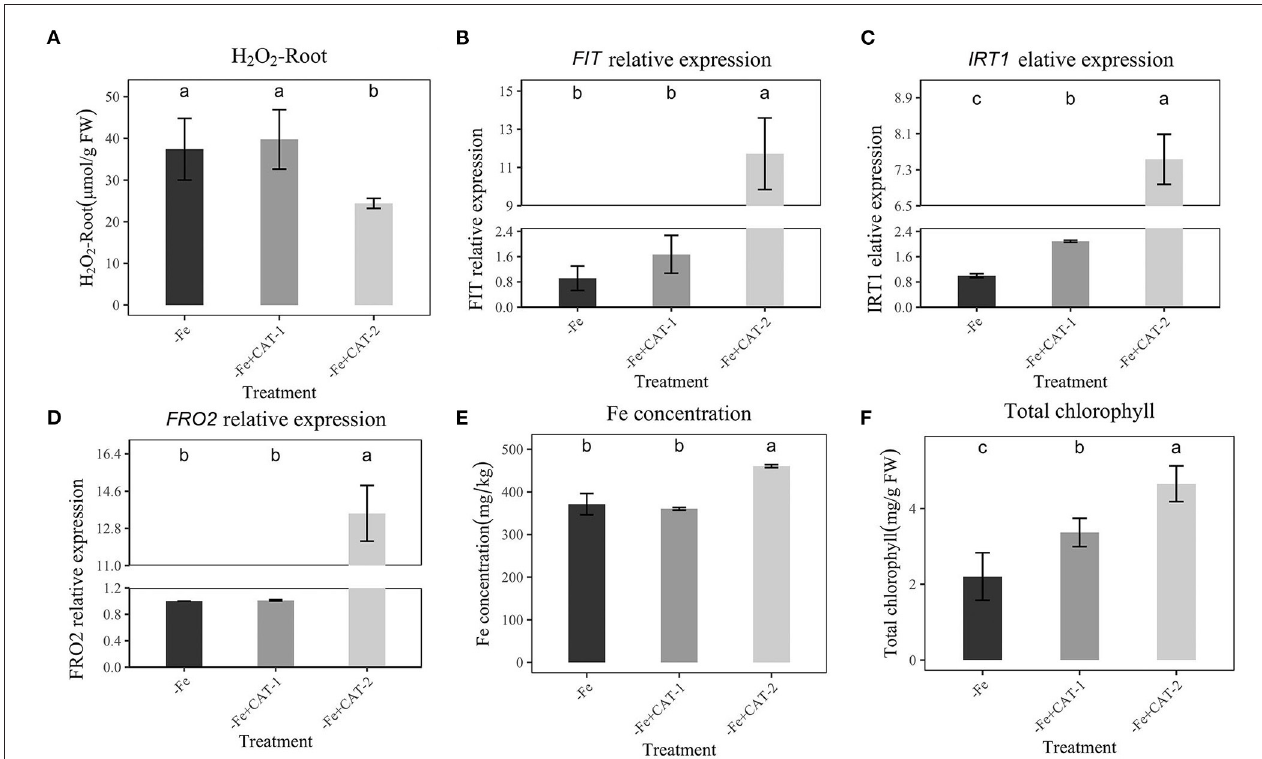
FIGURE 6 | Effects of Hoagland nutrient solution with different CAT concentration on peanut under Fe-deficiency (A) : Effects of Hoagland nutrient solution with different CAT concentration on H 2 O 2 content under Fe-deficiency. (B) : Effects of Hoagland nutrient solution with different CAT concentration on FIT expression under Fe-deficiency. (C) : Effects of Hoagland nutrient solution with different CAT concentration on IRT 1 expression under Fe-deficiency. (D) : Effects of Hoagland nutrient solution with different CAT concentration on FRO2 expression under Fe-deficiency. (E) : Effects of Hoagland nutrient solution with different CAT concentration on Fe concentration under Fe-deficiency. (F) : Effects of Hoagland nutrient solution with different CAT concentration on total chlorophyll content under Fe-deficiency. Data and errors are mean ± SD, n = 6, and different letters indicate significant differences among treatments. p < 0.05. -Fe = 2 µ mol FeEDTA in Hogland nutrition. CAT-1 and CAT-2 means two CAT concentrations (5 mKat/L, 10